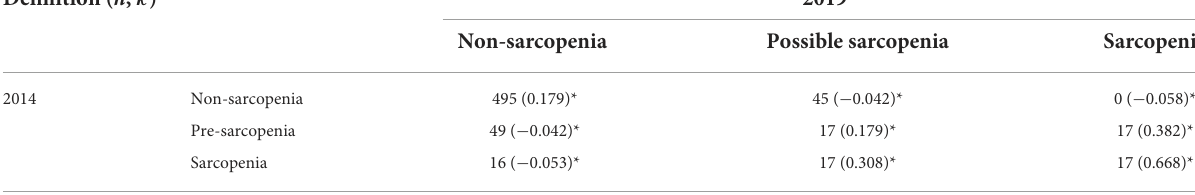
TABLE 3 Consistency between 2019 and 2014 AWGS definition in Taiwanese community-dwelling